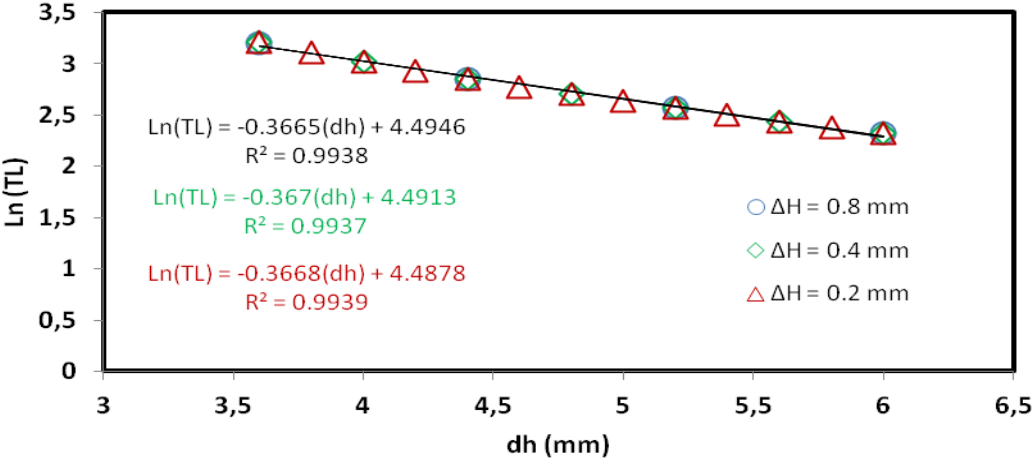
Figure 9. Change of the logarithmic toe length with the head difference for different head change magnitude.